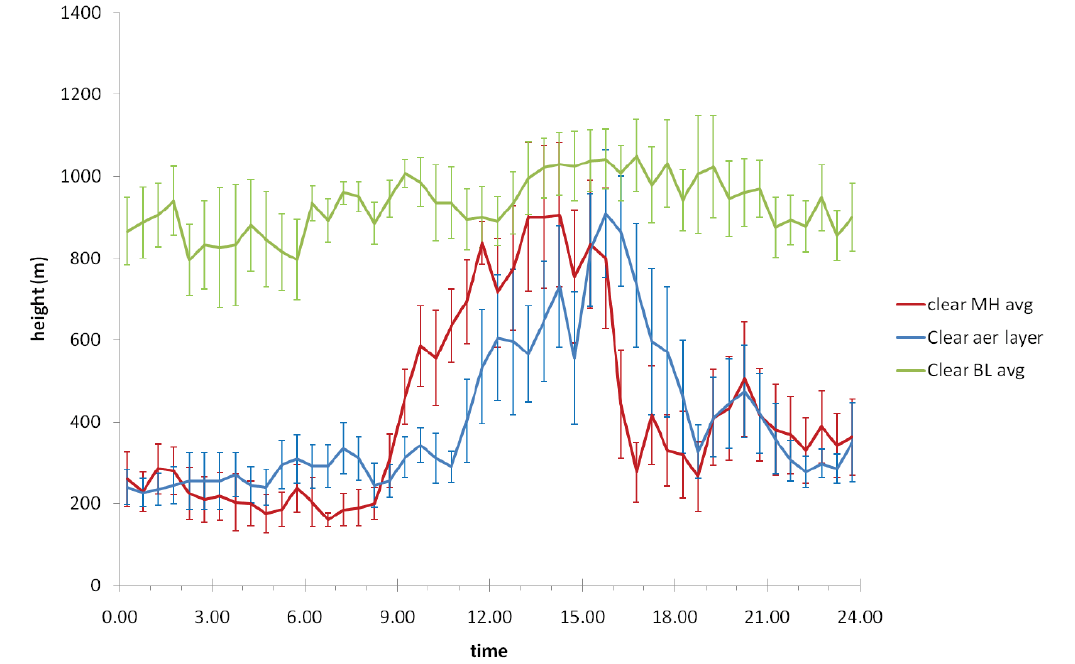
Figure 10. Plot of averaged boundary layer top (BL), backscatter-derived layer height (aerosol) and velocity-derived boundary layer (MH) for the diurnal cycle in clean sky conditions [145]. The boundary layer top was defined as a layer where there was a large gradient in backscatter. Error bars show standard